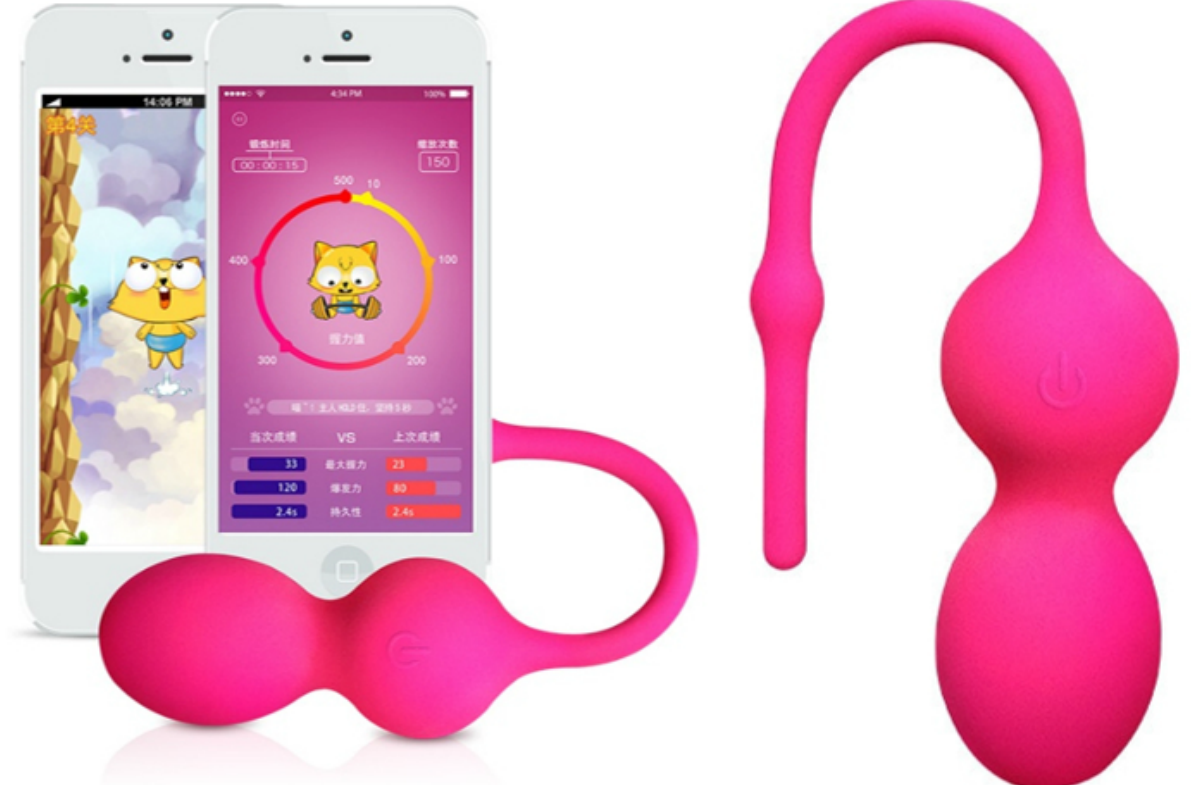
Figure 1. The mHealth iBall device. The iBall device consists of a Bluetooth antenna that sits outside of the body and 2 spherical compartments containing a battery and biofeedback sensor that sits within the vaginal